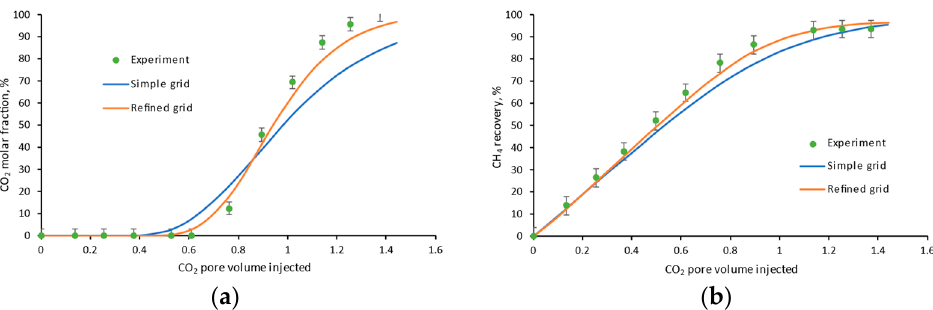
Figure 5. The fitting curves under 0.1 mL/min injection rate. ( a ) CO 2 content at the long core outlet; ( b ) CH 4 recovery.